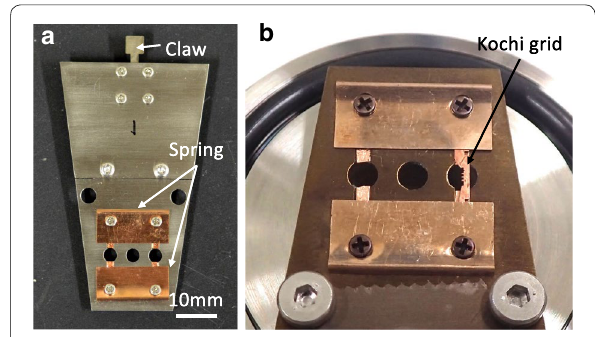
Fig. 4 Pictures of a the combined Okazaki cell, b the lower part of the Okazaki cell with the Kochi grid set inside an